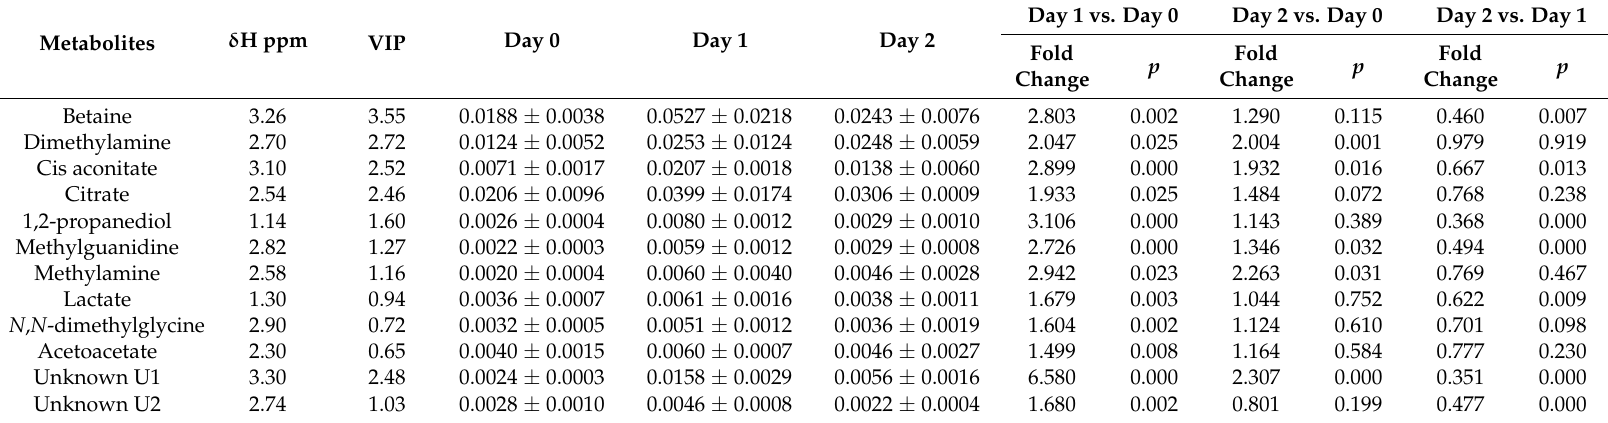
Table 3. Comparison of the significant urinary metabolite level changes of treated rat on Day 0, 1 and 2 and their respective variable importance in the projection (VIP) and p